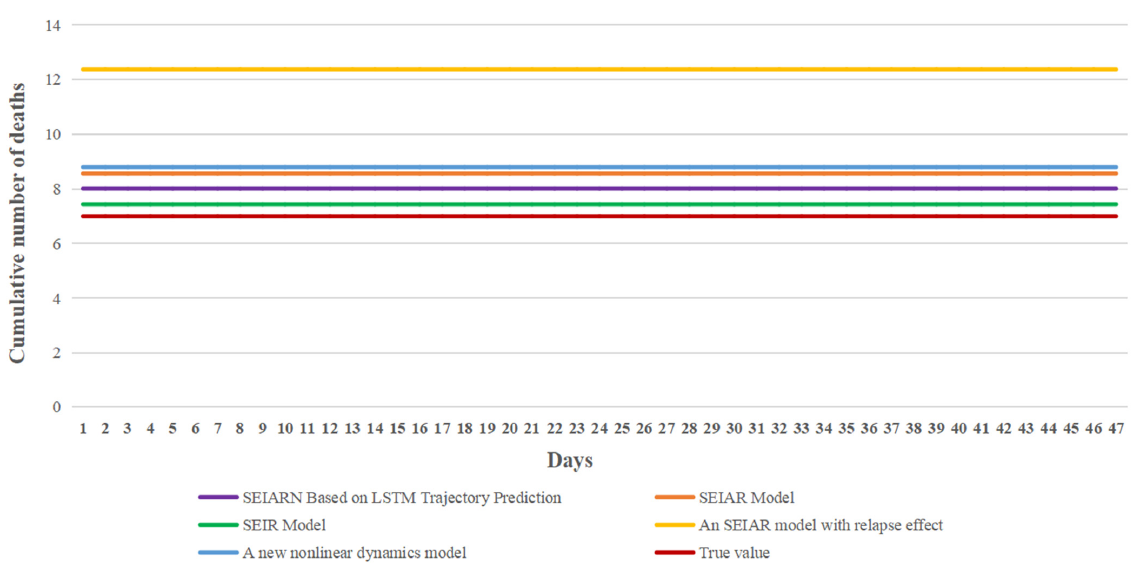
Figure 19. Comparison chart of the number of infected people.